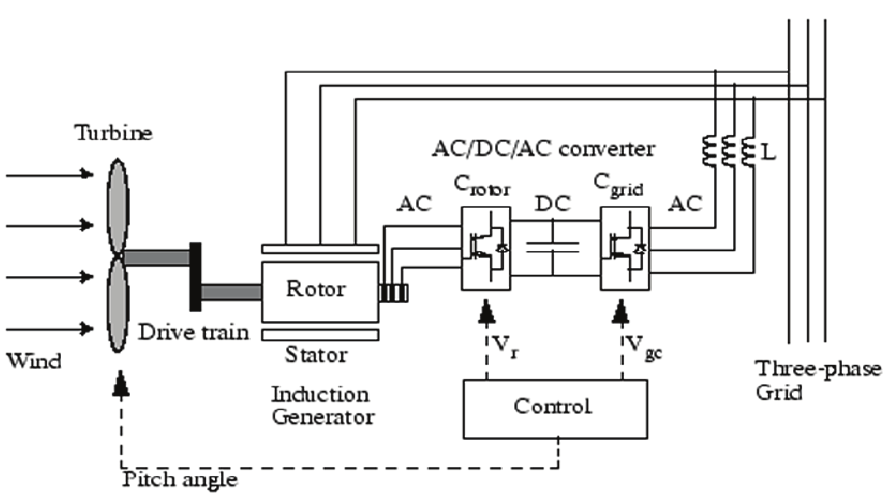
Figure 4. The wind turbine and the DFIG